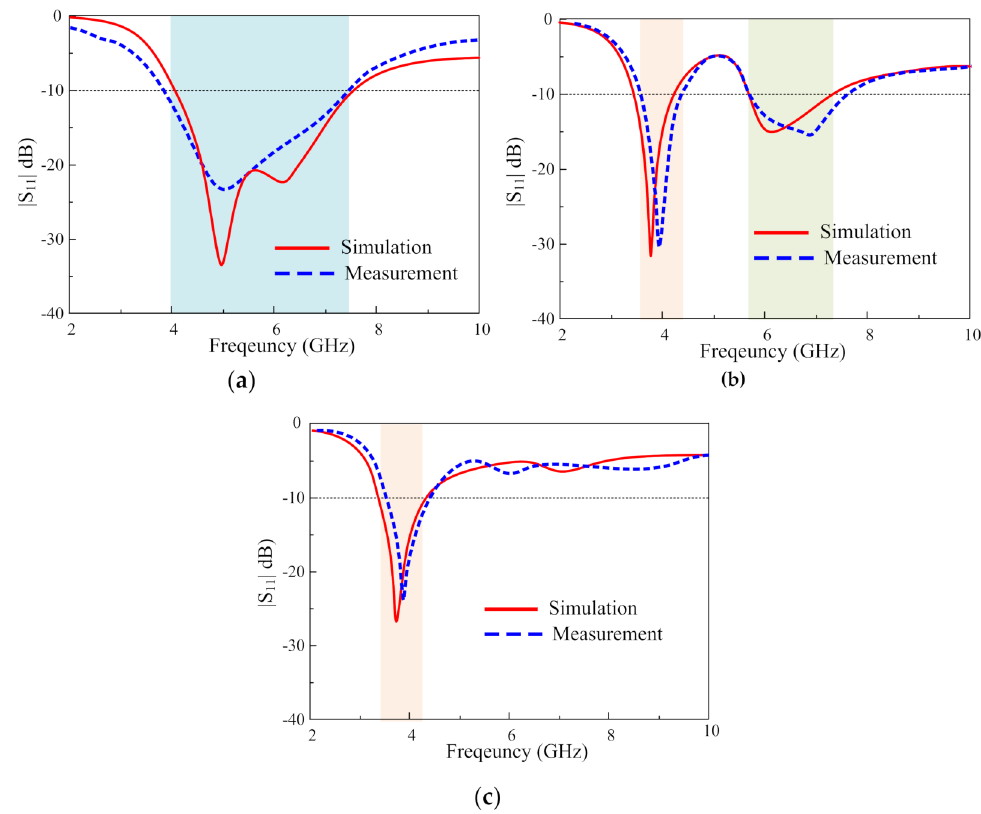
Figure 7. The simulated and measured |S 11 | for different operating modes ( a ) wide-band, ( b ) dual- band, and ( c ) single-band.